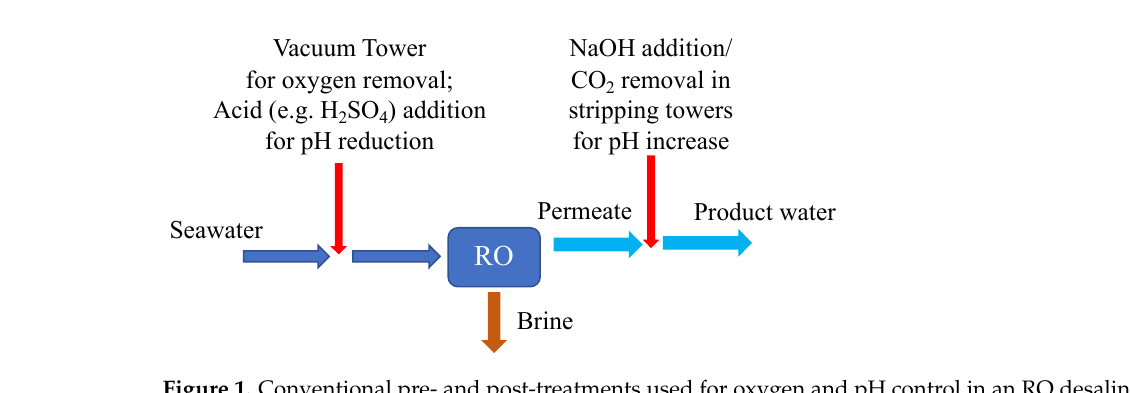
Figure 1. Conventional pre- and post-treatments used for oxygen and pH control in an RO desalination plant.